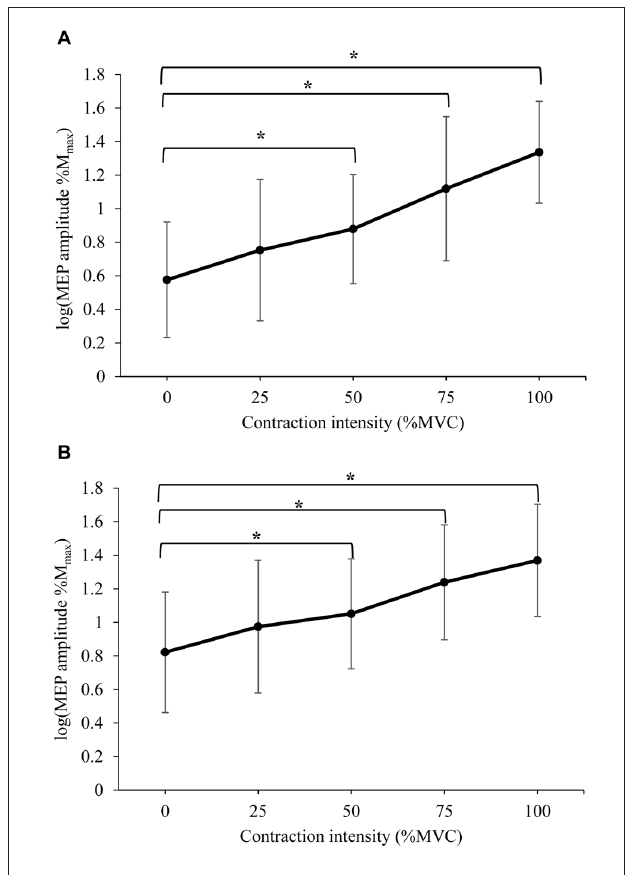
FIGURE 2 | Mean ± standard deviation (SD) peak-to-peak amplitude of motor evoked potentials (MEPs) delivered at (A) 120% resting motor threshold (RMT) and (B) 150% RMT, recorded from the resting right RF during isometric contraction of the left quadriceps. *Denotes significant difference in post hoc pairwise comparison ( p < 0.05). For MEPs collected at 120% RMT, contractions of 50%, 75% and 100% MVC produced a 96%, 300% and 425% increase in MEP amplitude, respectively. For MEPs collected at 150% RMT, contractions of 50%, 75% and 100% MVC produced a 66%, 155% and 229% increase in MEP amplitude, respectively.